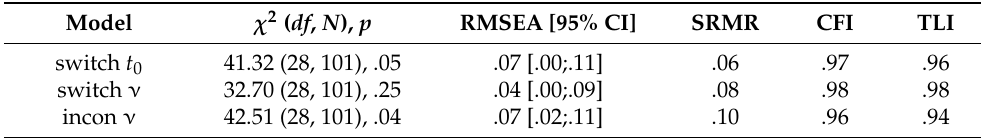
Table 2. Fit of the LDS models for DM parameters.